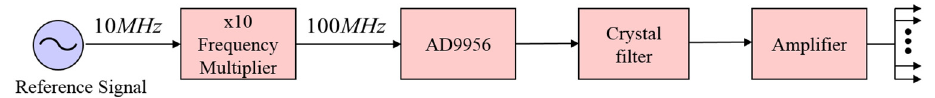
Figure 3. A block diagram of the frequency offset generator.